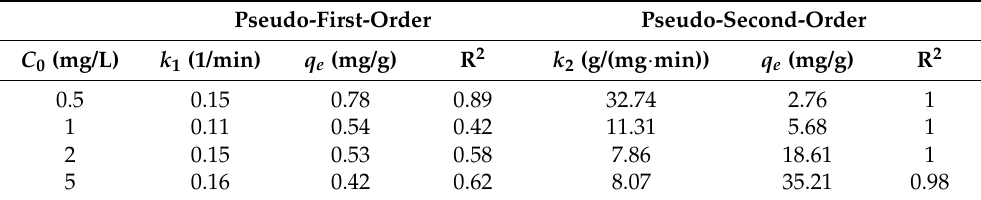
Table 2. Model parameters of adsorption kinetics of CB on TCS in water.